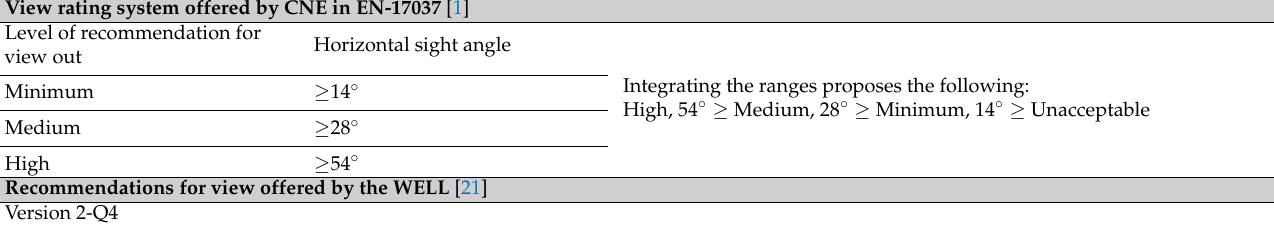
Table 1. Existing rating systems and recommendations for view access to